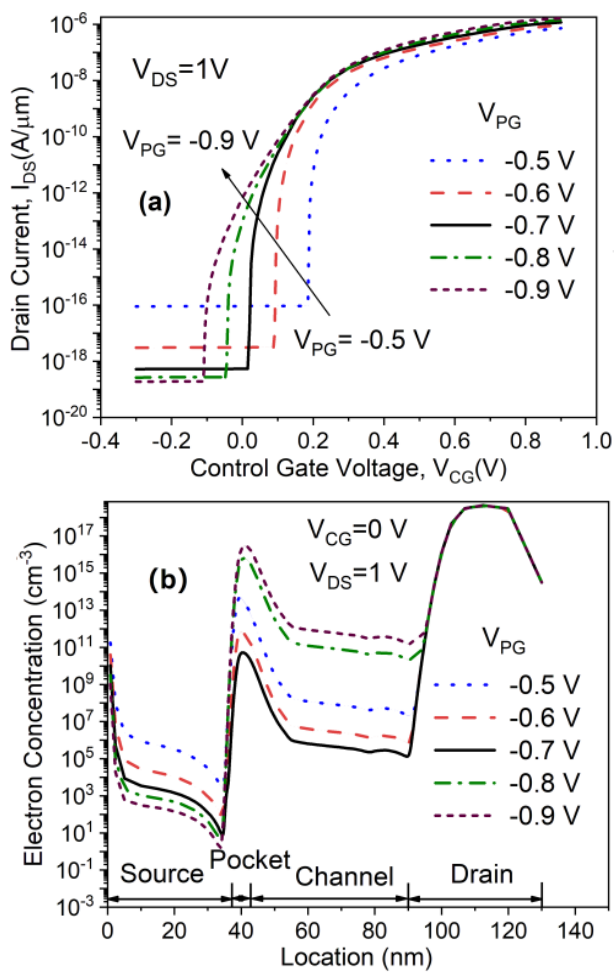
Figure 7. Impact of polarity gate (PG) bias on ( a ) transfer characteristics and ( b ) electron concentration of the in-built N + pocket ED-TFET.